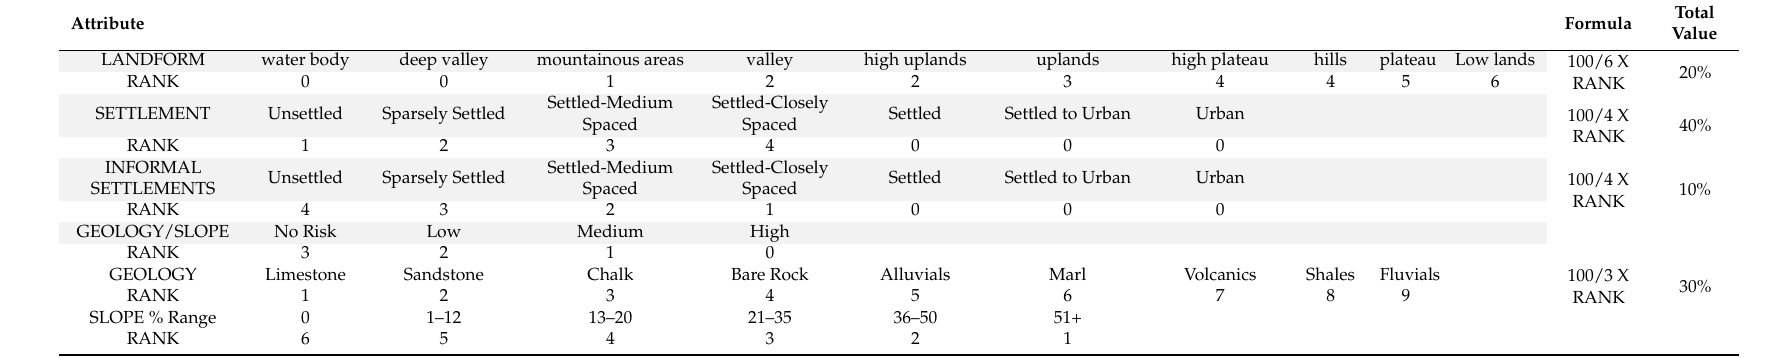
Table 2. Intensification of Urban sprawl: Assessment and